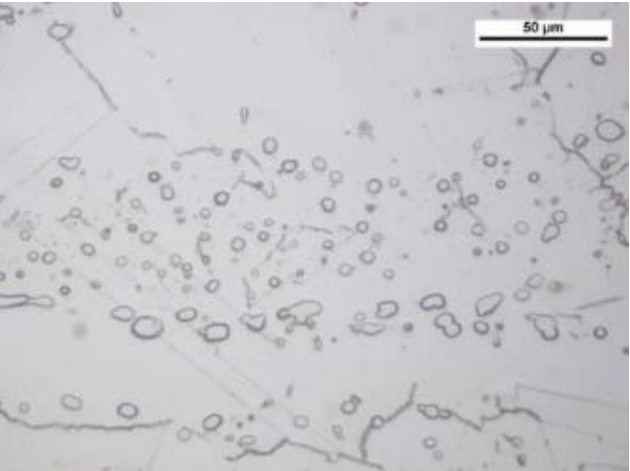
Figure 8. High-nickel austenite with banded carbide precipitates M 23 C 6 . Light microscopy. Mi30Fe, a sample material subjected to a total strain of 0.6% at 650 °C, was etched.